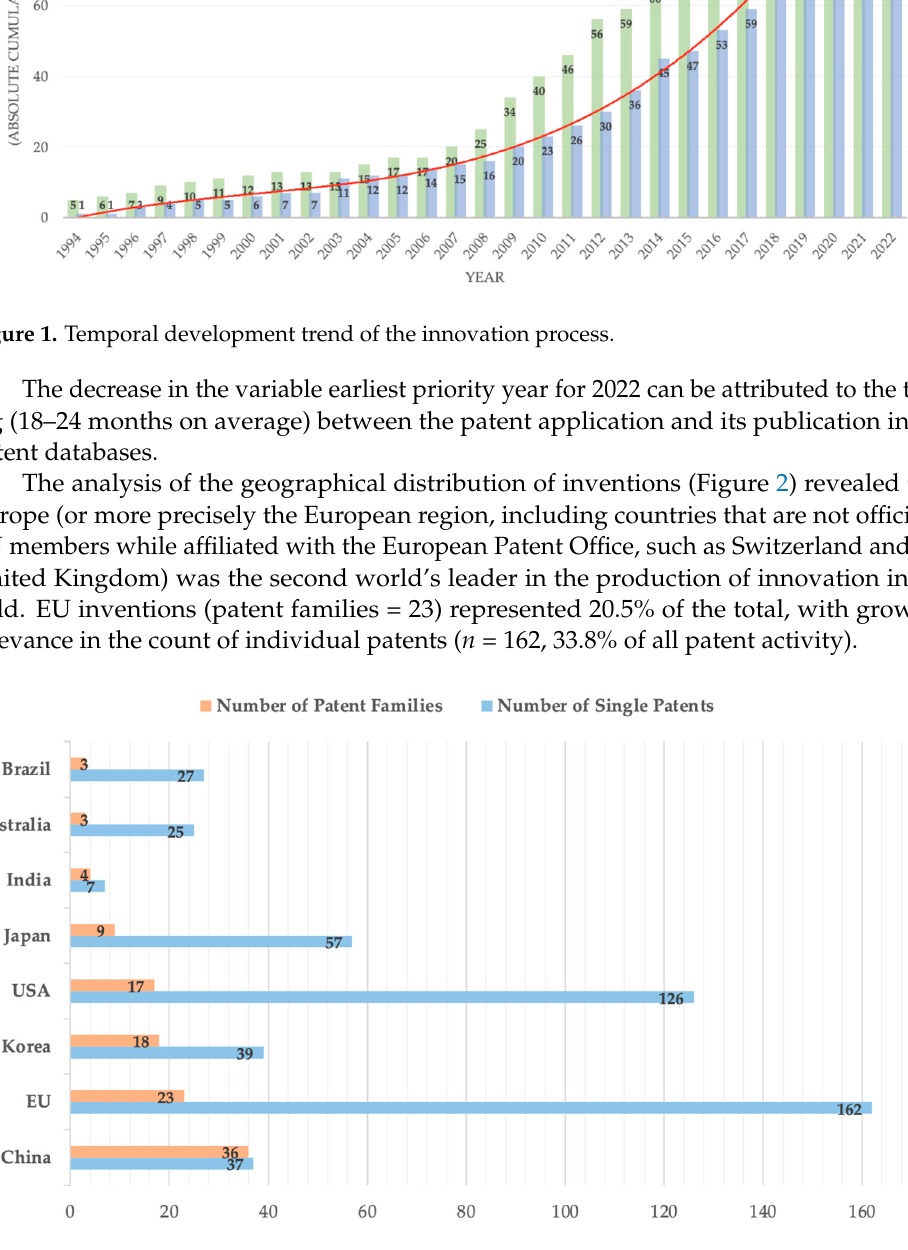
Figure 2. Number of patent families and individual patents by priority country.